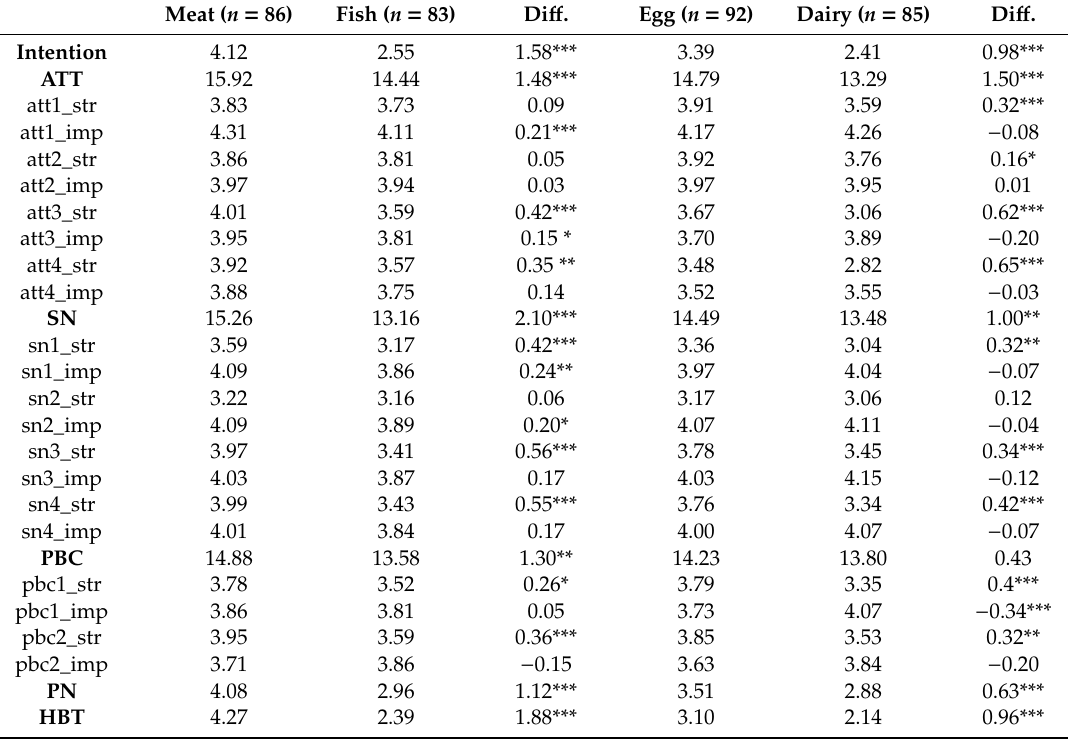
Table 4. Di ff erences in belief strength and importance evaluation by food